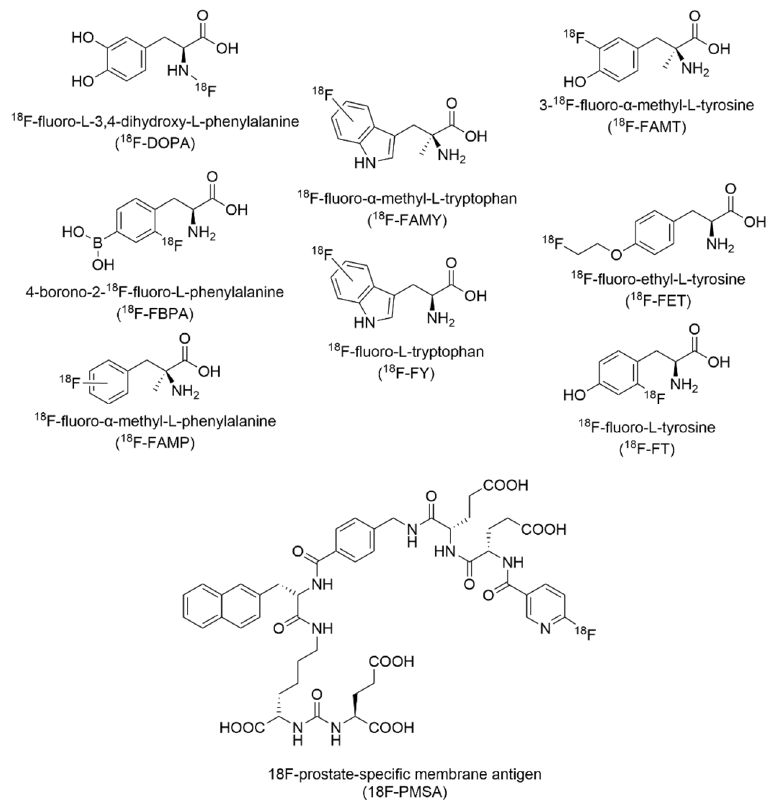
Figure 18. Chemical structures of some 18 F-L- α -amino acid radiotracers that have been deployed for use as PET diagnostics.